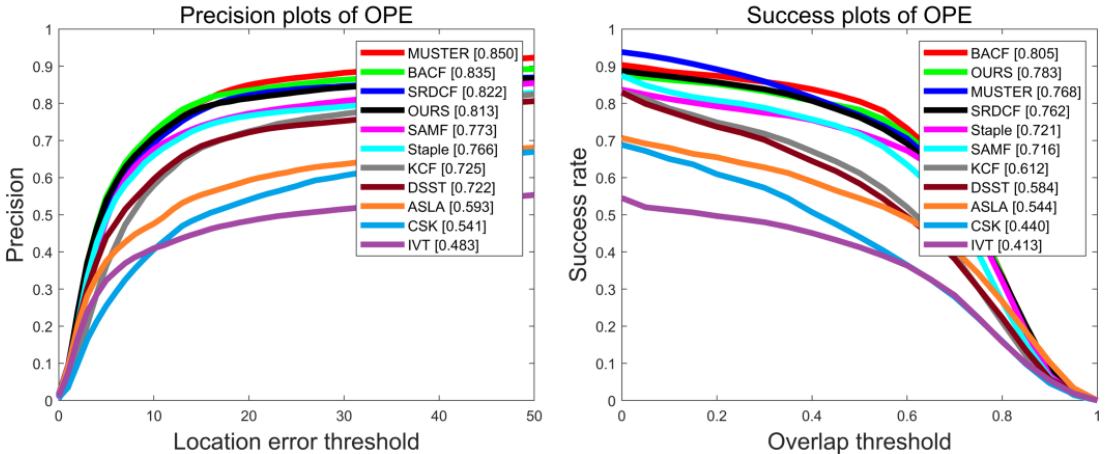
Figure 11. Accuracy and success rate plots of different algorithms tested on the OTB-2013 dataset. Table 2. Average performance of algorithms tested on the OTB-2013 dataset.